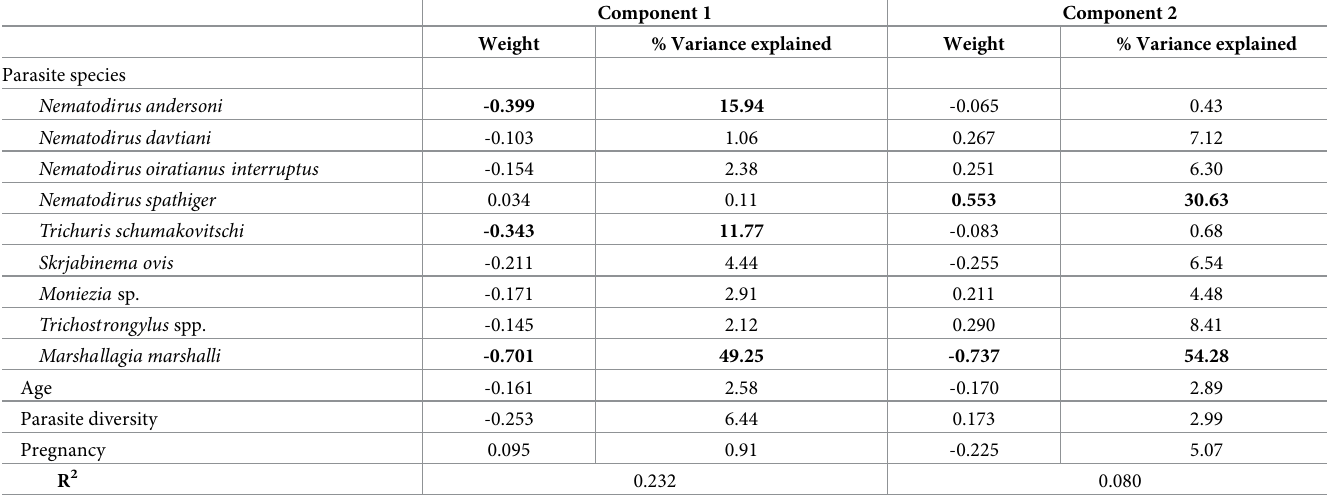
Table 4. Results of the Partial Least Squares Regression (PLS-R) explaining the effects of several gastrointestinal parasite species on body condition in adult female Dall’s sheep (n = 39).